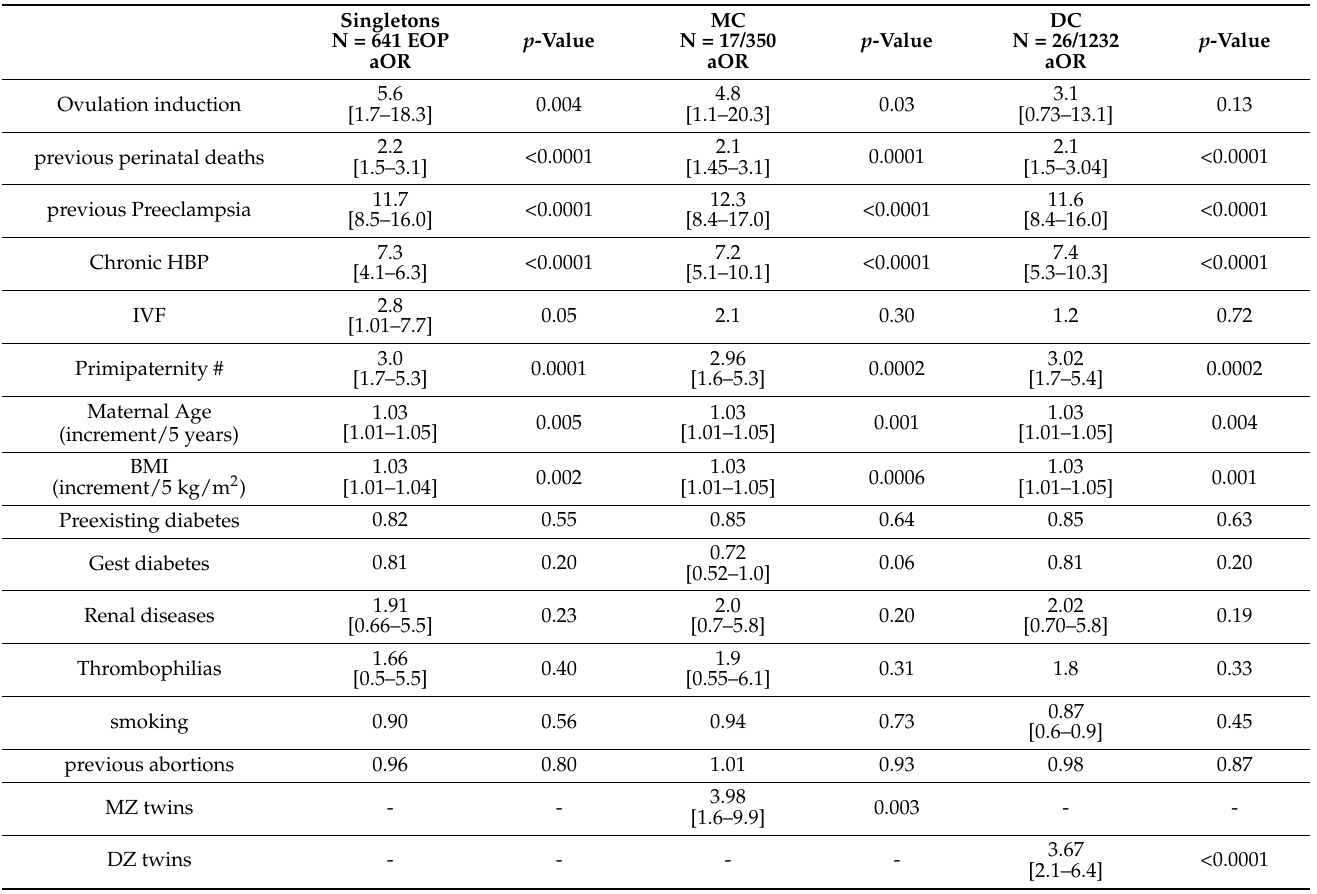
Table 3. Adjusted Odds ratios. Outcome: EARLY ONSET preeclampsia EOP. Three logistic models including (1) singletons (2) monochorionic (3) dichorionic twins. Preeclamptic women PE (N = 2001), EOP (N = 641), LOP (N = 1360) versus controls, normotensive women (N =